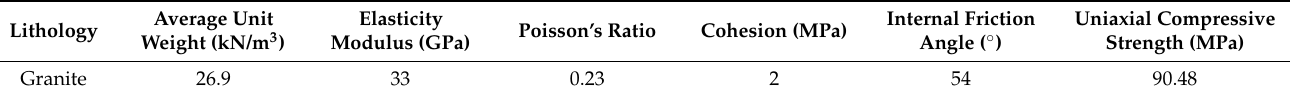
Table 6. Physical and mechanical parameters of surrounding